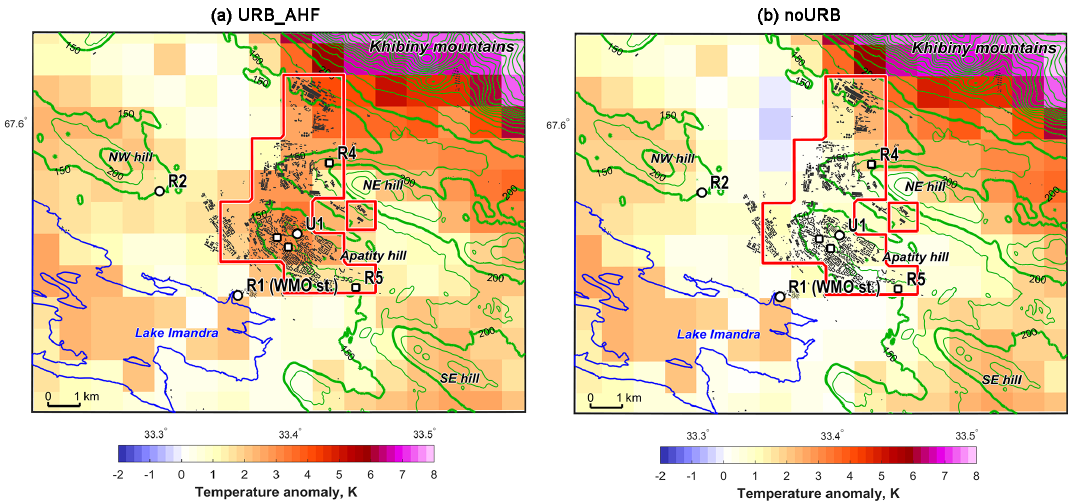
Figure 8. The maps of the simulated surface air temperature anomalies, averaged over all six selected cold periods as indicated in Fig. 7. The COSMO-CLM simulations with the TERRA_URB urban scheme and prescribed anthropogenic heat flux (URB_AHF) is shown in (a) , and those without the urban scheme (noURB) are shown in (b) . The anomalies were defined as the deviation from the model grid cell corresponding to the R1 site. The urban land use/land cover was introduced in the grid cells encompassed by the red outline.